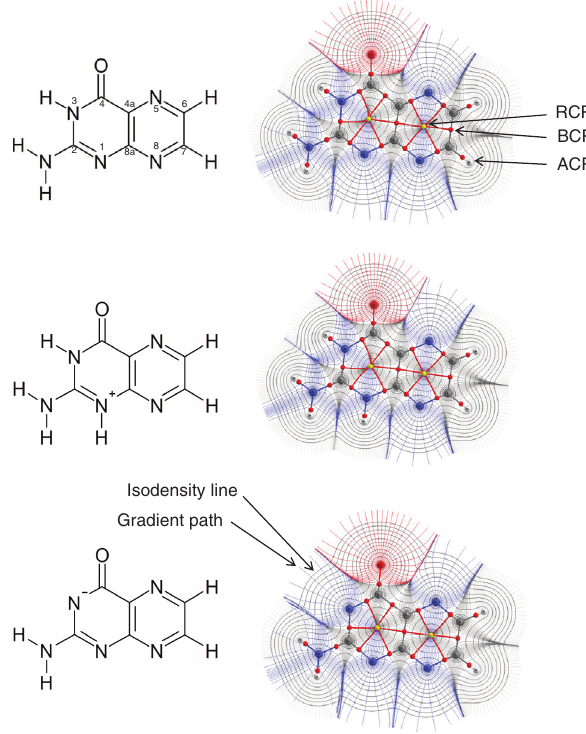
Figure 1 Chemical formulae (left column) and plots of the electron density as well as the gradient paths (right column) of neutral (top), cationic (middle) and anionic (bottom) pterin. The formula for neutral pterin also shows the conventional numbering of the ring atoms. “Normal” gradient paths are shown as thin lines perpendicular to the isodensity lines and are coloured according to their respective atoms (red, oxygen; blue, nitrogen; dark gray, carbon; light gray, hydrogen). “Special” paths such as bond paths (connecting ACP and BCP) and ring paths (connecting BCP and RCP) are shown as thick red lines. The outermost isodensity contour is at 0.001 a.u. Other lines are at 0.002, 0.004, 0.008, 0.02, 0.04, 0.08 … a.u. of electron density. ACP, atomic critical points (larger dots coloured according to the respective atom); BCP, bond critical points (red dots); RCP, ring criti- cal points (yellow